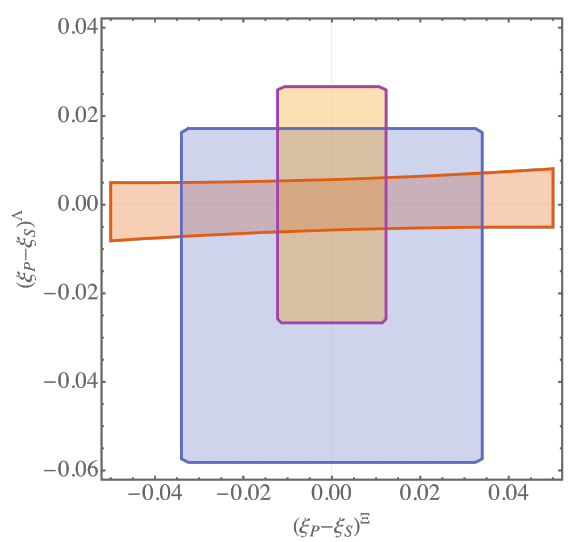
Figure 2. Summary of the results for the weak phases ( ξ P − ξ S ) Ξ and ( ξ P − ξ S ) Λ . The present BESIII results are given by the blue rectangle [13, 14]. The red horizontal band is the HyperCP result [17]. The brown rectangle is the projection of the statistical uncertainties for the complete BESIII data